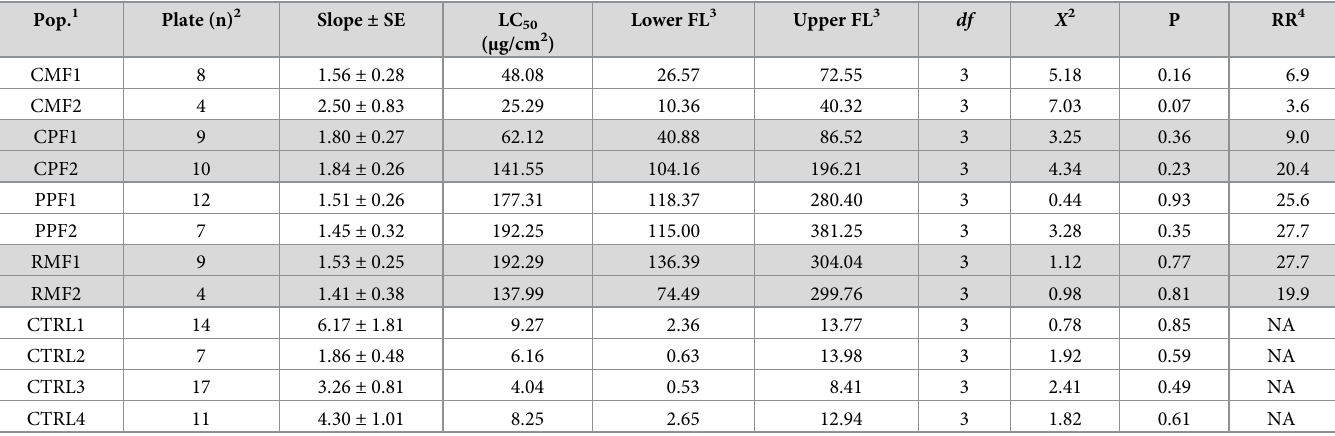
Table 4. Pobit analysis of larval mortality in diet-based